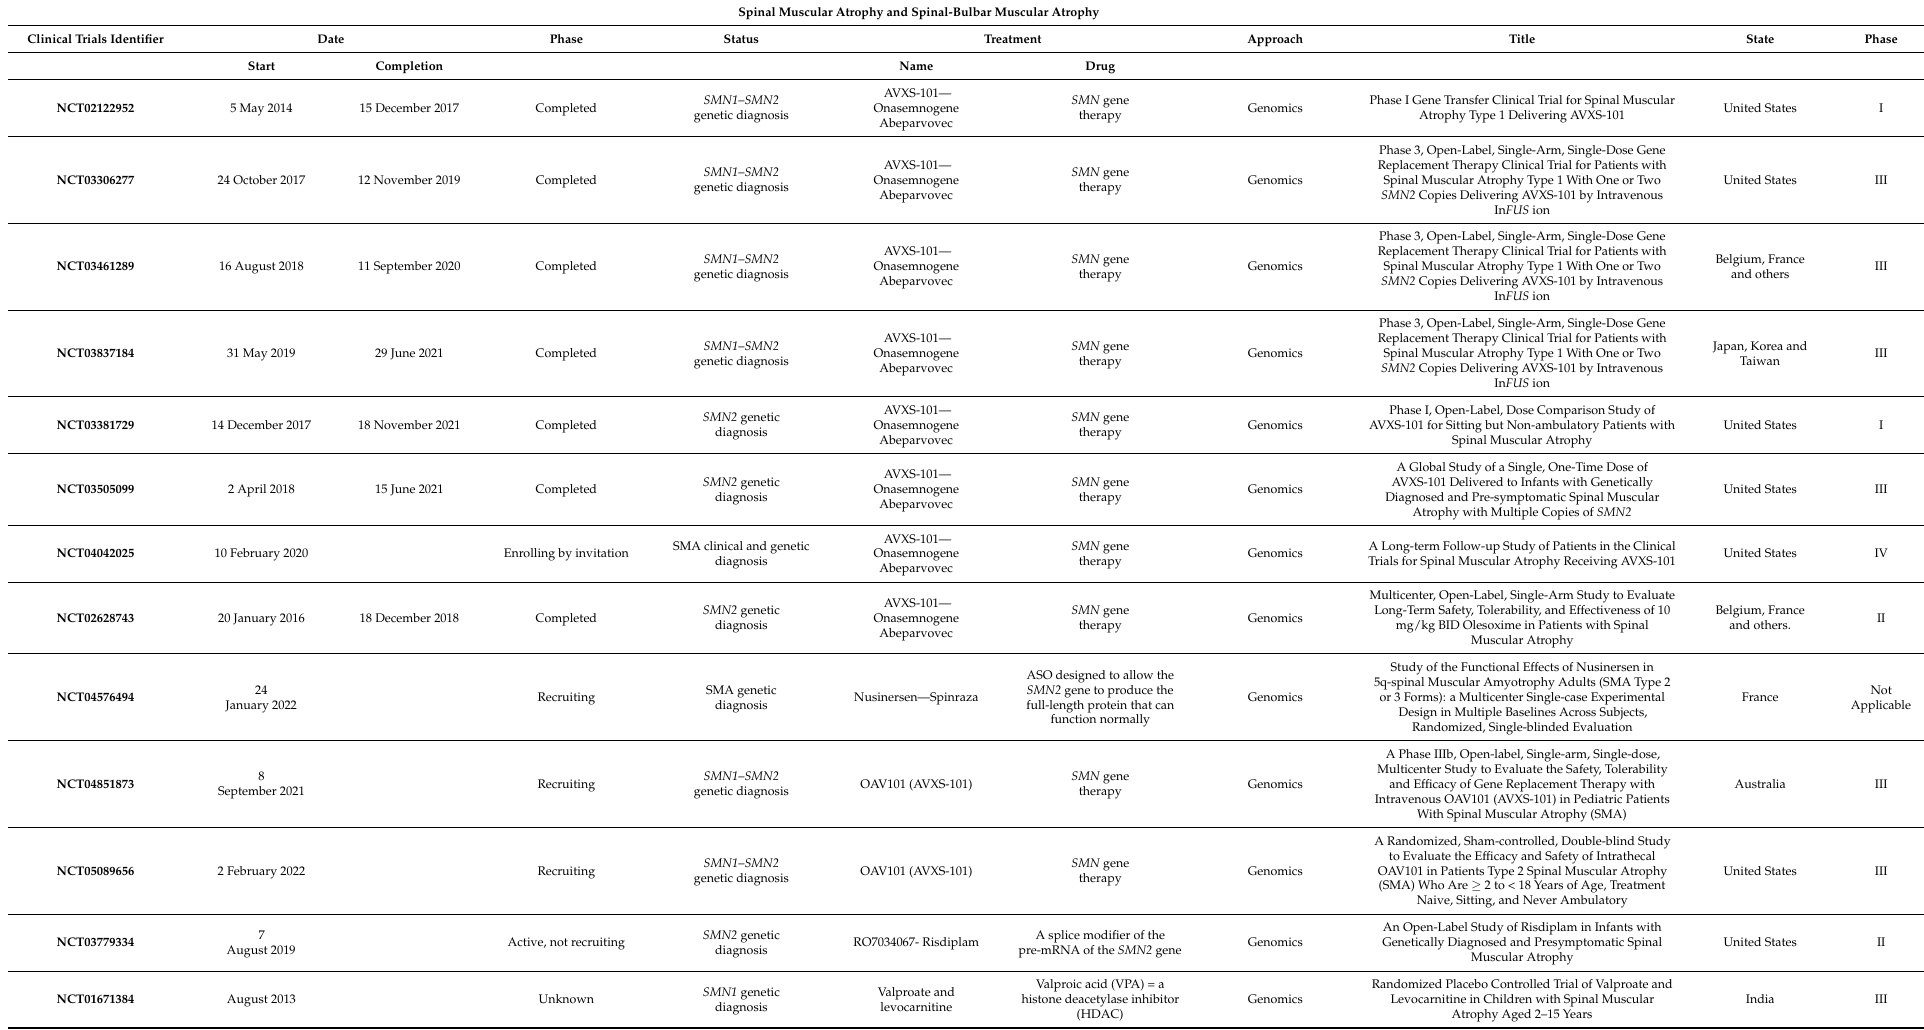
Table 2. List of clinical trials carried out on SMA and SBMA using different omics